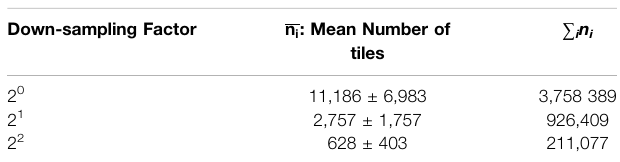
TABLE 1 | Mean number of tiles. Down-sampling Factor